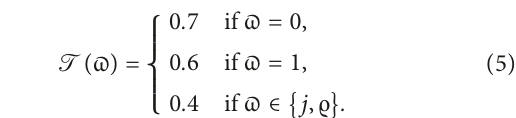
operation ( ∗ ) described in Table 3.